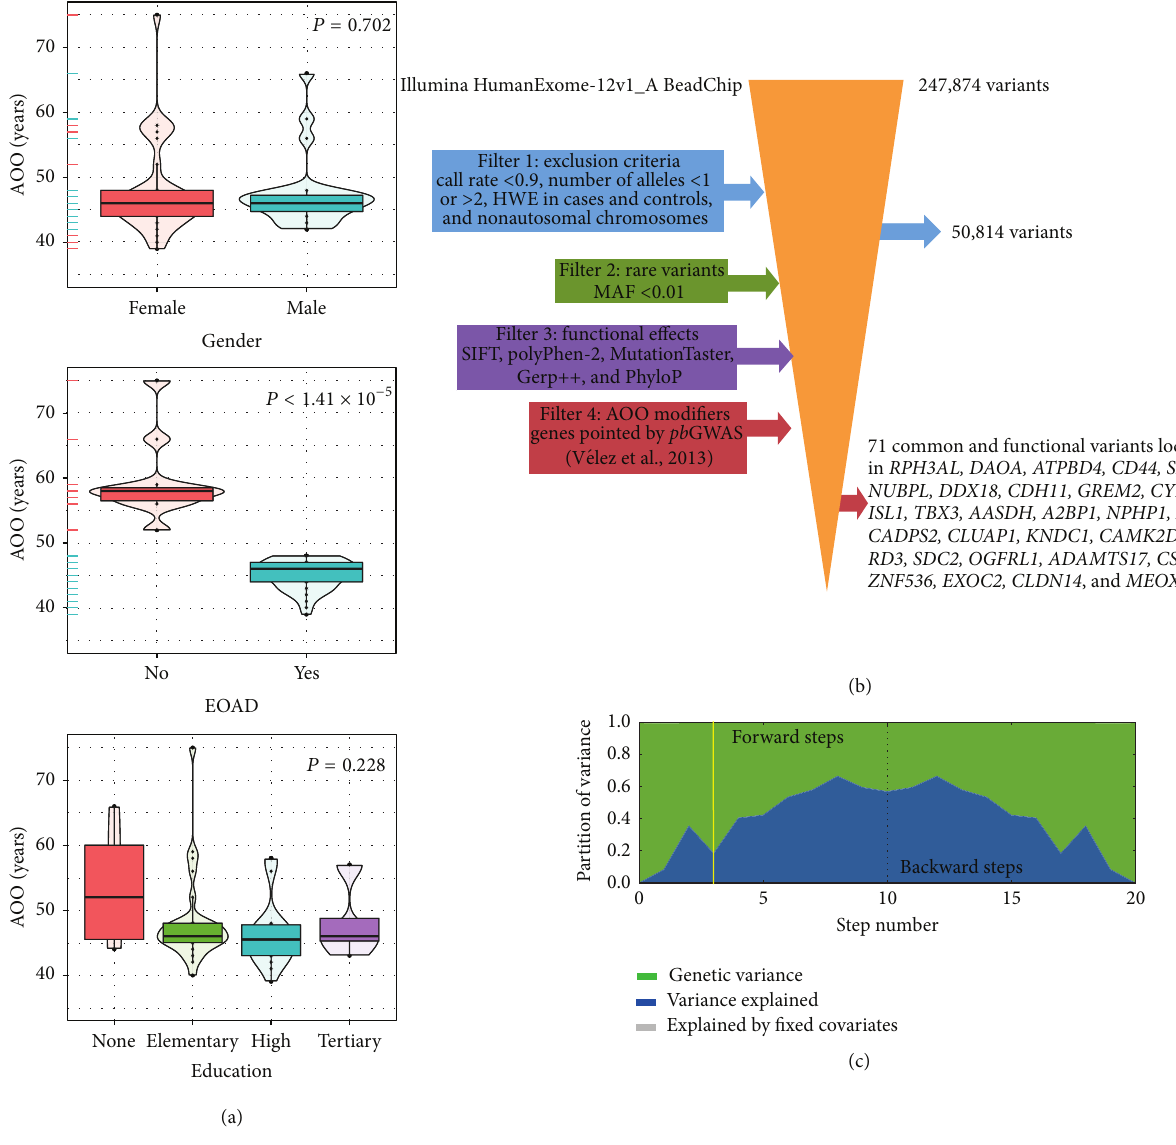
Figure 1: (a) Box- and violin-plots for the AOO of AD by gender (top), early-onset (middle), and level of education (bottom) in 60 patients carrying the PSEN1 E280A mutation. The associated 𝑃 value after testing for differences in the average AOO is shown. AOO: age of onset; AD: Alzheimer’s disease; EOAD: early-onset Alzheimer’s disease. (b) Filtering workflow of exonic variants leading to the selection of 71 variants harboured in genes associated with modifiers of the AOO of AD in carriers of the PSEN1 E280A mutation as reported by V´elez et al. [18]. Abbreviations as in (a). (c) Partition of phenotypic variance for each forward inclusion (steps 1 to 10) and backward elimination (10 steps after the dotted line). The yellow vertical line marks the model selected based on the lowest Bayesian Information Criterion